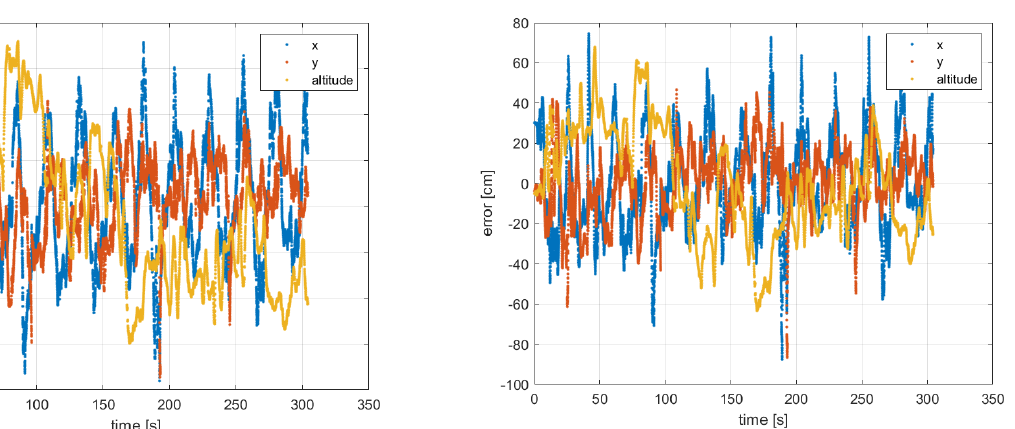
Figure 4. Errors on the UWB position estimates in the EKF1 case.